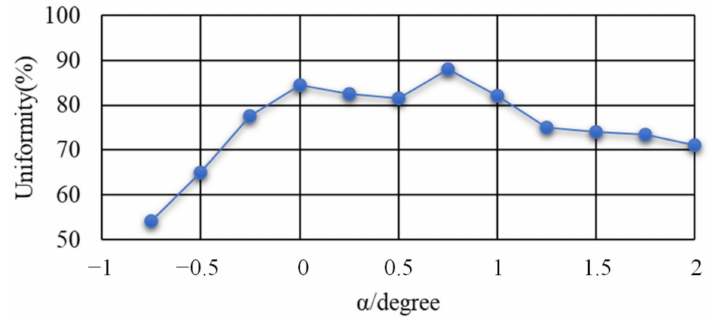
Figure 17. Variation curve of uniformity with the